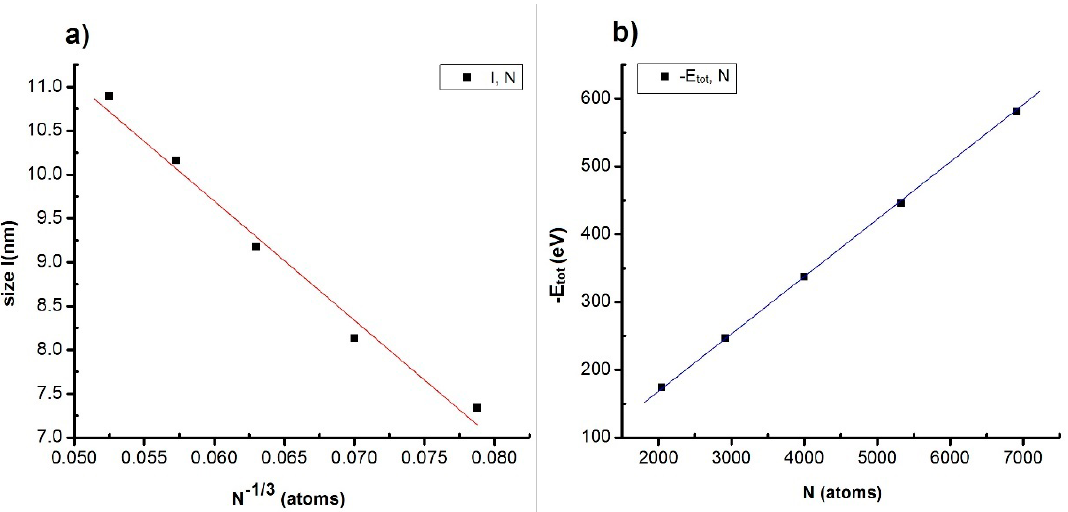
Figure 5. The relationship between characteristic quantities such as structures as dependence between l, N ( a ); − E tot , N ( b ) of the NiAu alloy with different N.